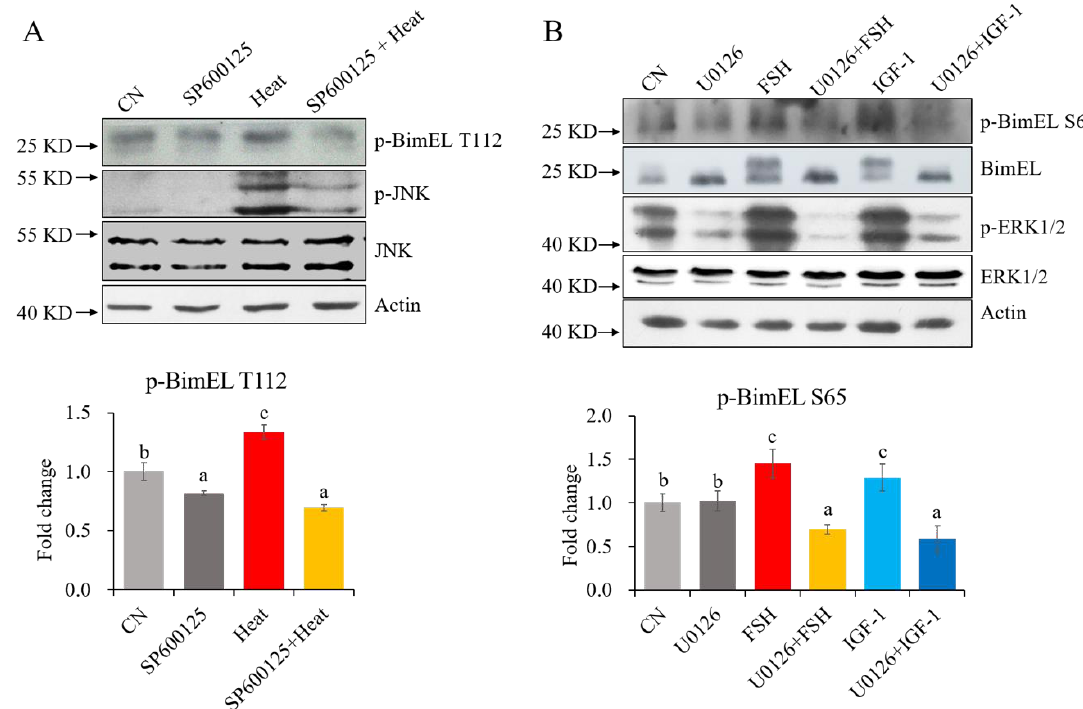
Figure 5. The possible pathways of p-BimEL S65 and p-BimEL T112 regulated by different factors in porcine granulosa cells. ( A ) The treatment of SP600125 blocked the increase of BimEL T112 phosphorylation induced by heat stress. ( B ) The treatment of U0126 hindered the increase of BimEL S65 phosphorylation induced by FSH or IGF-1. CN = untreated, Heat = heat stress at 42 ℃ for 12 h, IGF-1 = treated with 100 ng/mL IGF-1 for 24 h, FSH = treated with 0.01 IU/mL FSH for 24 h, U0126 = treated with 20 μM U0126 for 24 h, SP600125 = treated with 20 μM SP600125 for 12 h; p-BimEL S65 = phosphor-BimEL-Ser65; p-BimEL T112 = phosphor- BimEL-Thr112. The cells were harvested, and equal amounts of proteins were used for immunoblotting. Values are expressed as the means ± SD of three separate experiments. The bars labeled with completely different letters indicate significant difference, P < 0.05.